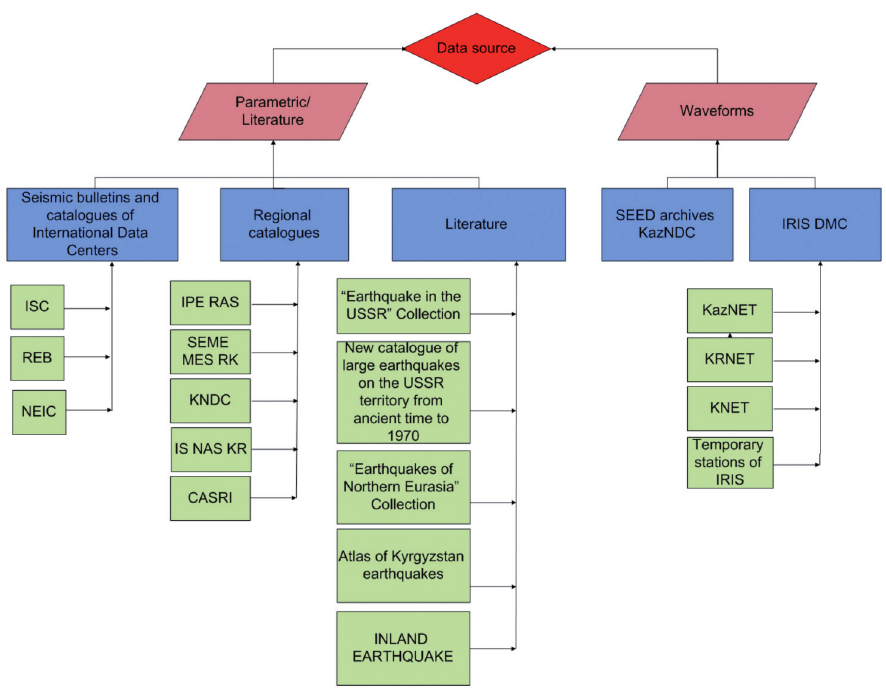
Figure 2. The sources used to compile the EMCA